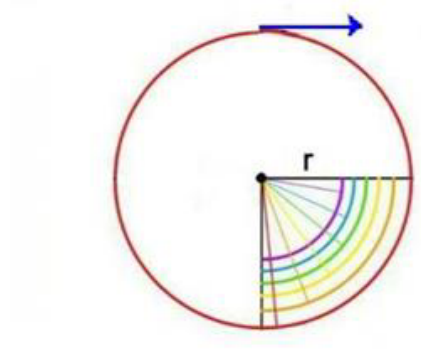
Fig. 2. Front view of photon motion of photon